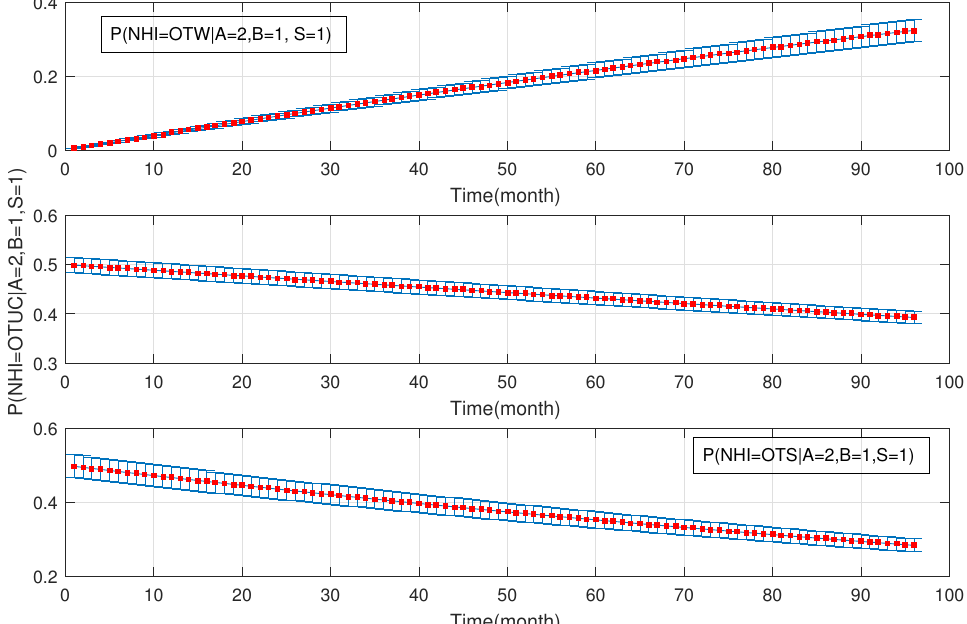
Figure 13. The probability of new herd incident (NHI) (officially TB free status withdrawn (OTW), officially TB free status unclassified (OTUC), officially TB free status suspended (OTS)) in high-risk areas of England for A: cattle ≤ 24 months, where B: badgers density is > 3 setts/ ha; and S: silage